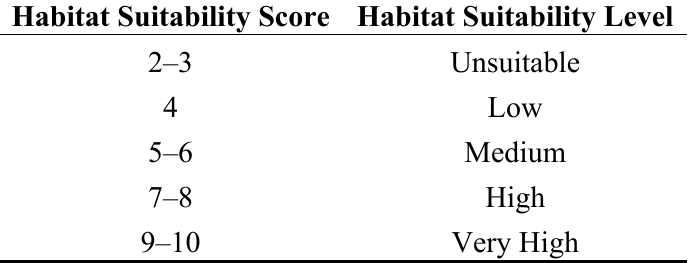
Table 2. Potential habitat levels assigned to the resulting habitat